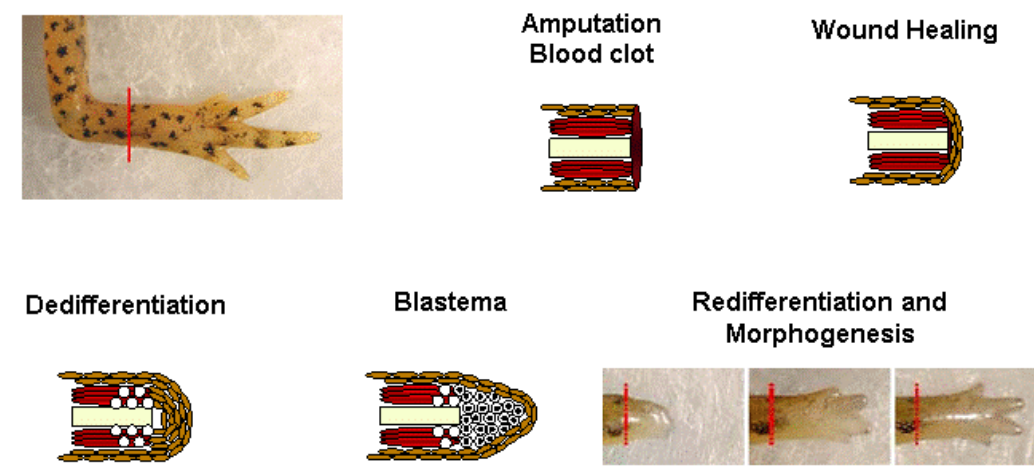
FIGURE 1. Stages of newt forelimb regeneration. On amputation of the newt forelimb, a fibrin clot is formed and epithelial cells migrate to cover the wound. Dedifferentiation ensues and is accompanied by a thickening of the wound epithelium to form the AEC. The multipotent cells that are generated by the dedifferentiation process then proliferate to form the blastema. During subsequent stages, blastema cells redifferentiate, resulting in the regeneration of the lost forelimb. , amputation site; , blood